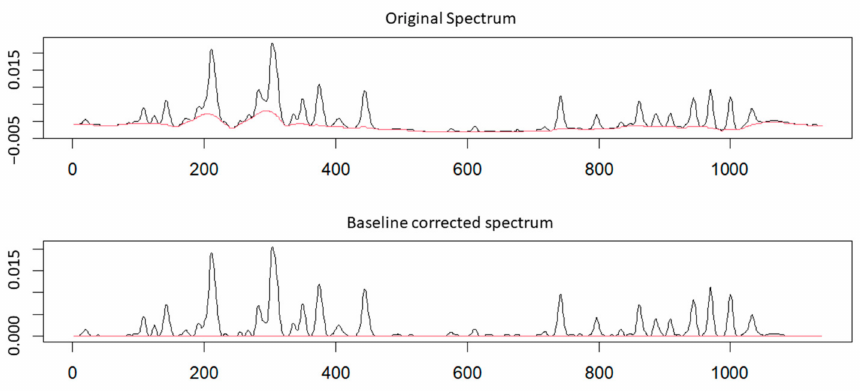
Figure 1. Original chromatogram and baseline corrected chromatogram after applying the “Iterative baseline correction algorithm based on mean” algorithm from “baseline” package in RStudio.